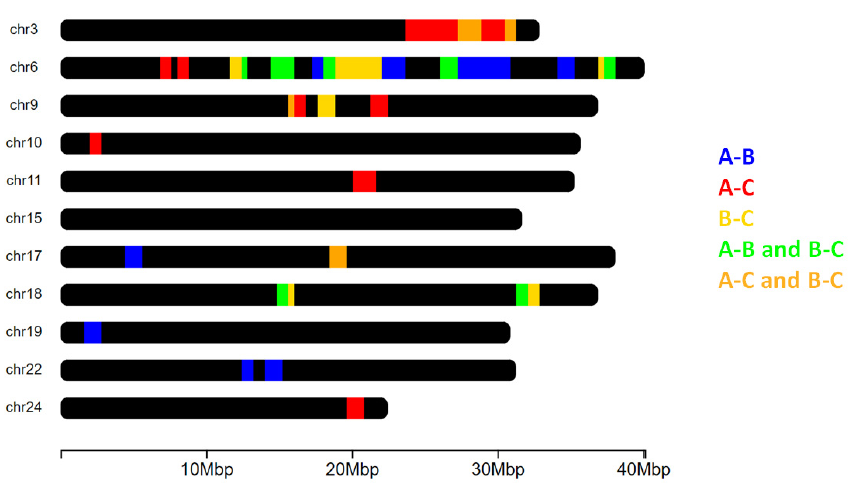
Figure 4. Overview of the chromosomes (chr) in which signatures of selection were detected. The x axis shows the chromosome length. The chromosomes that did not include any highlighted regions were not reported.